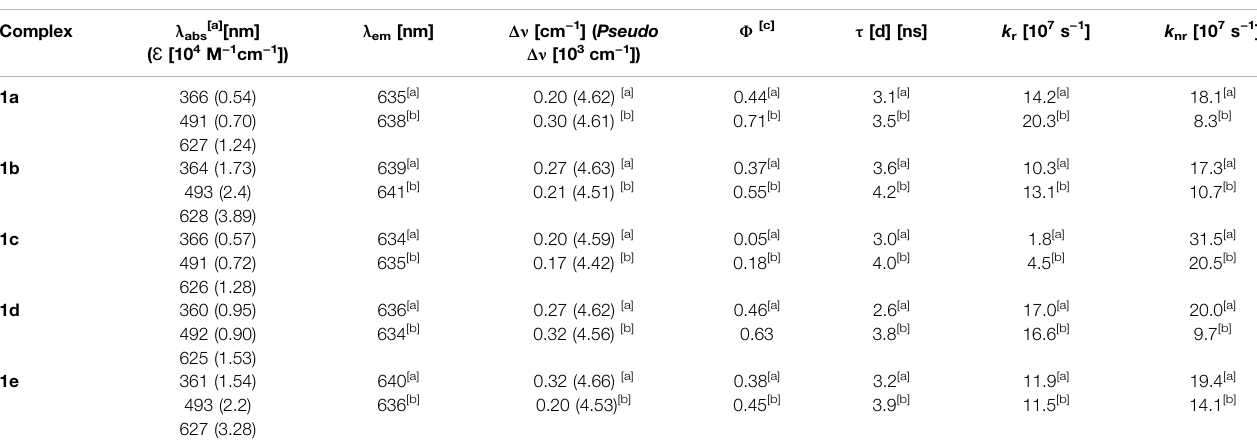
TABLE 1 | Photophysical properties of heteroleptic Zn II complexes 1a-e